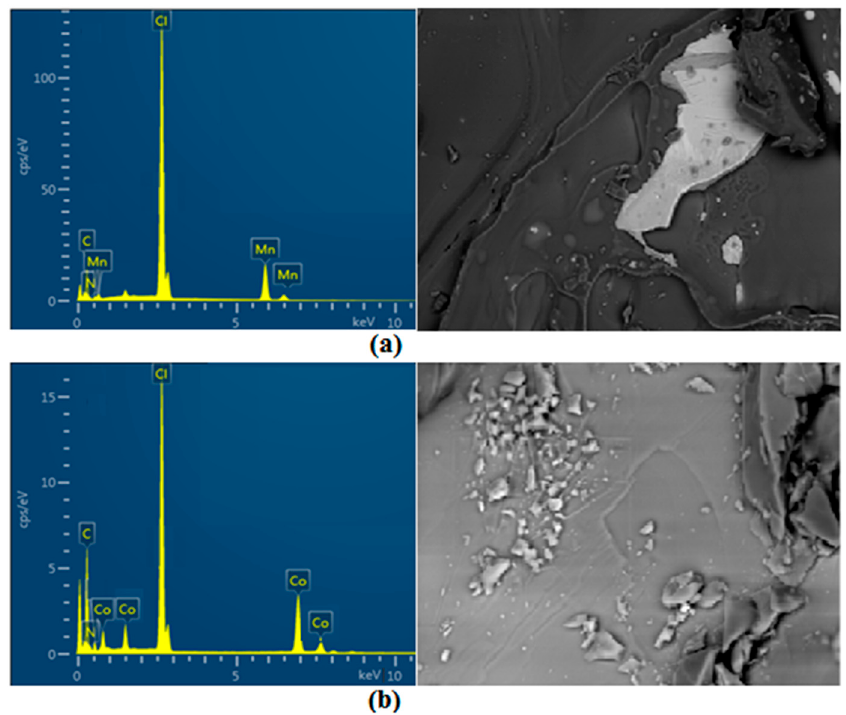
Figure 1. ( a ) EDX (left)and SEM (right)of images of compound ( I ). ( b )EDX (left) and SEM (right) of images of compound ( II ).